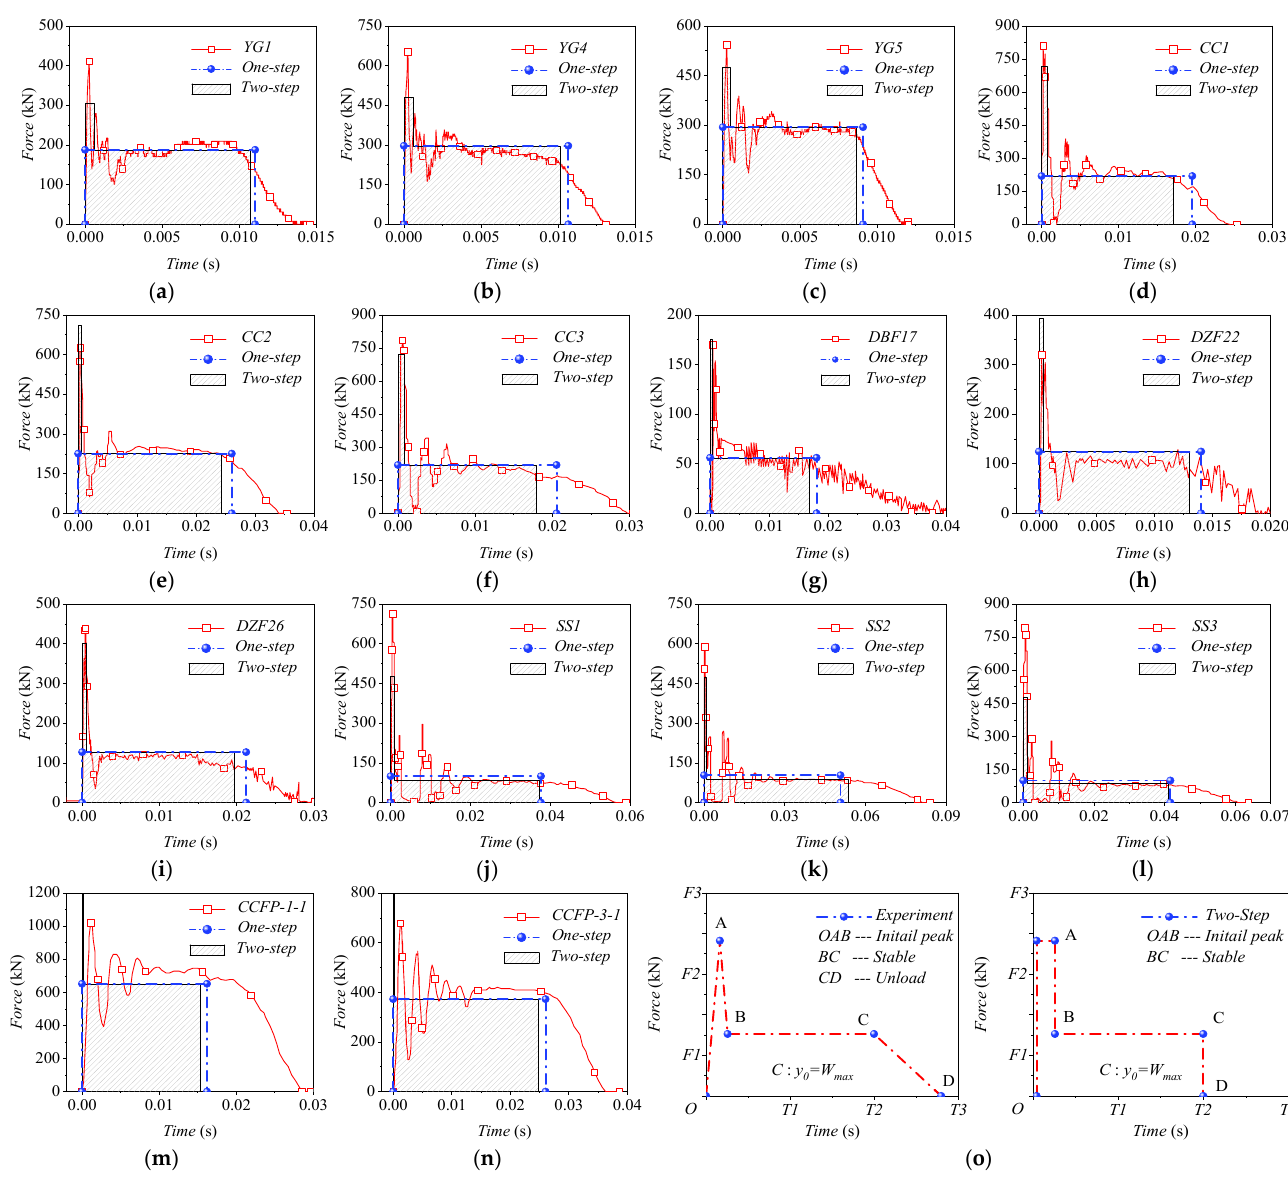
Figure 5. Impact contact force versus time curve of tests and calculations. ( a ) YG1; ( b ) YG4; ( c ) YG5; ( d ) CC1; ( e ) CC2; ( f ) CC3; ( g ) DBF17; ( h ) DZF22; ( i ) DZF26; ( j ) SS1; ( k ) SS2; ( l ) SS3; ( m ) CCFP-1-1; ( n ) CCFP-3-1; ( o ) Resistance mode in the tests and two-step method. Table 2. Design results from the one-step